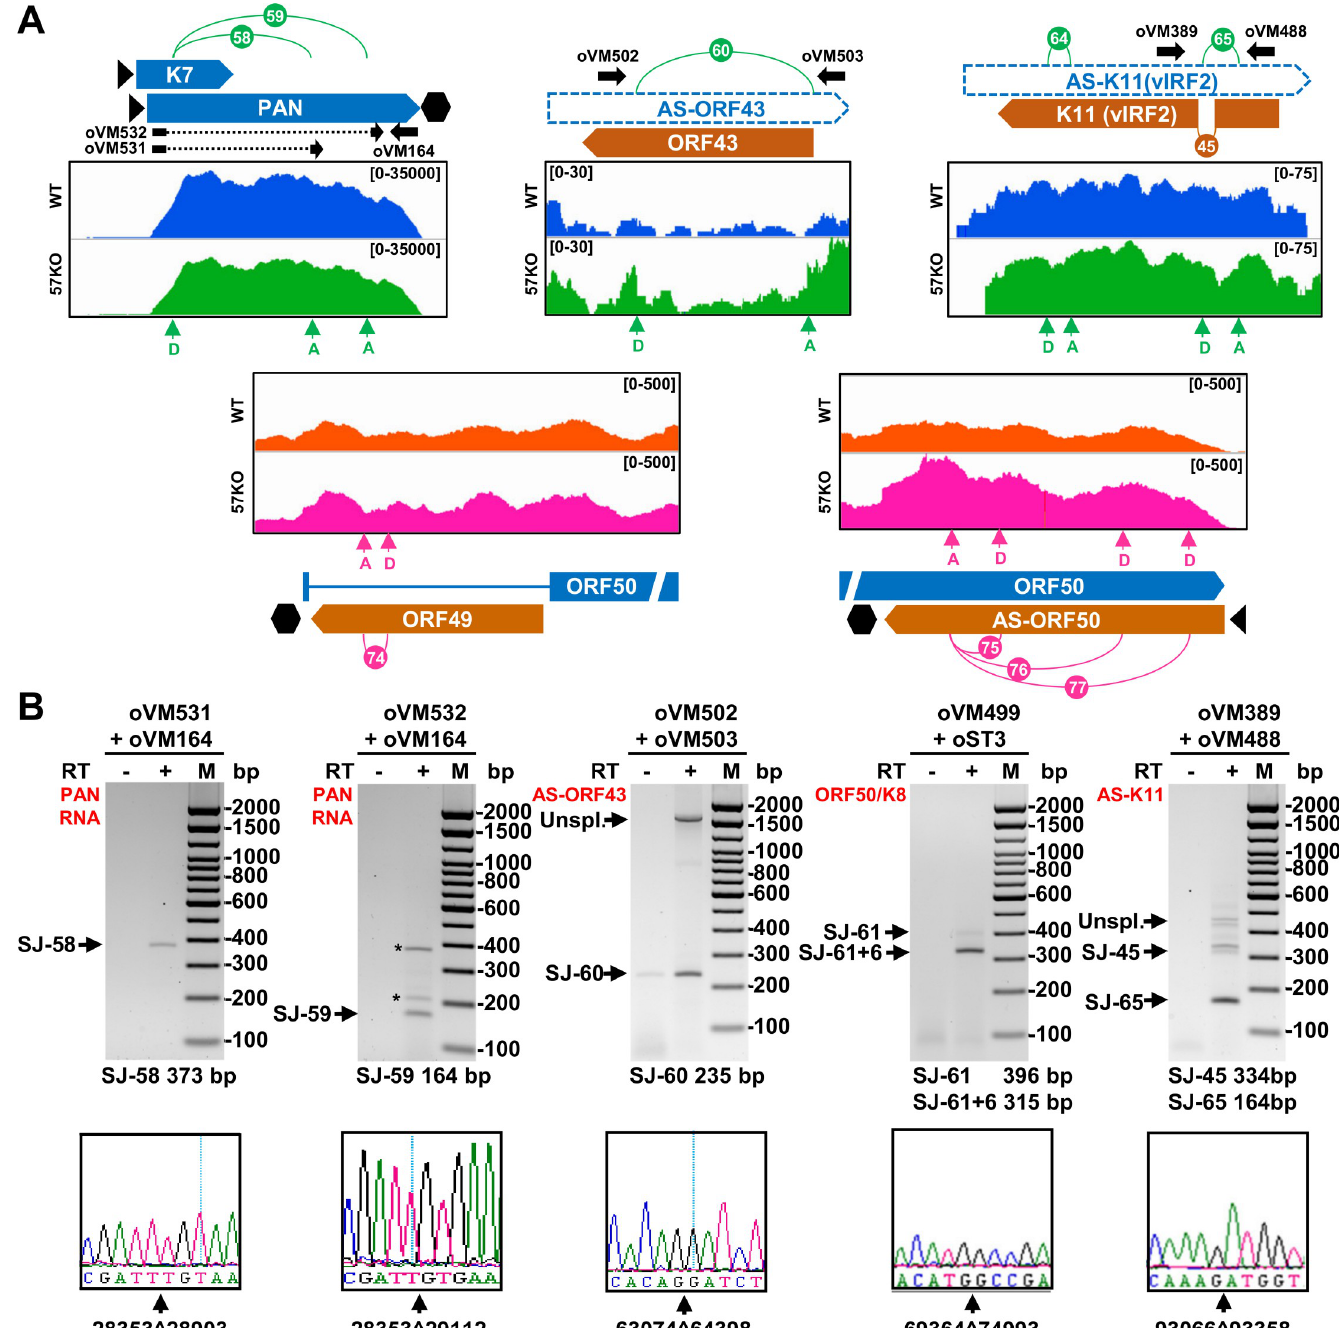
Fig 6. Mapping of 57KO-specific splice junctions in intronless and antisense viral transcripts. (A) The RNA splice junctions supported with � 10 splice reads from the 57KO genome were mapped to intronless viral transcripts. See Figs 3 and 4 for a detailed description. (B) RT-PCR validation of selected 57KO-specific RNA splicing events using total RNA from BCBL-1 57KO cells treated with VA for 24 h. The sizes of expected amplicons with indicated primer pairs in the presence of reverse transcriptase (+RT) are shown below, together with the chromatographs from Sanger sequencing confirming the mapped splice junctions. The asterisks ( � ) mark the non-specific RT-PCR amplicons. SJ-61+6 means a RT-PCR product from the double RNA splicing first from the splice junction SJ-61 and then SJ-6 (see Fig 3 ).